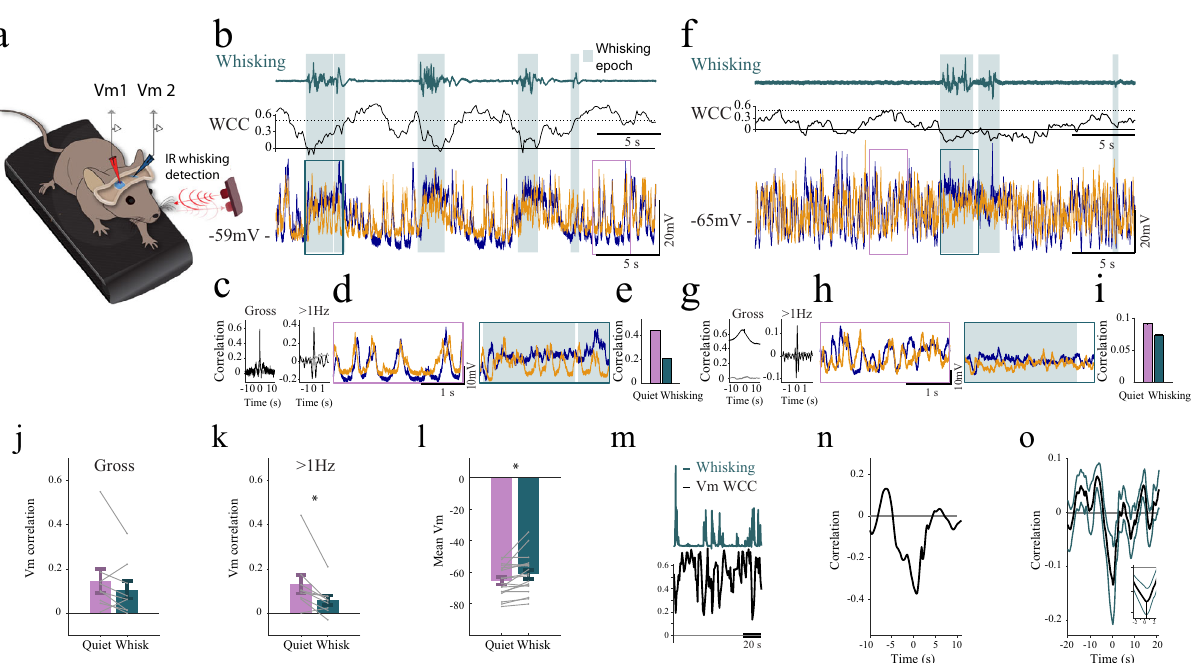
Fig. 2 Decorrelation of interhemispheric subthreshold activities during whisking. a Schematic diagram of paired whole-cell patch-clamp recordings simultaneously from both hemispheres. b An example of simultaneous dual whole-cell recordings from the right (orange) and left (blue) barrel cortices during quiet wakefulness and whisking epochs (teal background), along with the corresponding whisking activity (upper panel) and a running window membrane potential (Vm) cross-correlation (WCC, middle panel). c Cross-correlation of the membrane potential of the two neurons (shown in b ) for raw data (left) and following fi ltering above 1 Hz (right). d Expanded portions of membrane potentials during quiet wakefulness (pink frame) and whisking epochs (teal frame), showing epoch of low and high correlated activities (left, right, respectively), e The mean subthreshold cross-correlations during quiet wakefulness and whisking epochs for the example in b (mean ± SEM, quiet n = 82847, whisking n = 13154, WSRT P < 0.0001, n refers to the number of steps in the running cross-correlation). f – i Same as b – e but for another example pair (for i , mean ± SEM, quiet n = 542692, whisking n = 168311, WSRT P < 0.001, n refers to the number of steps in the running cross-correlation). j Interhemispheric subthreshold correlation during quiet wakefulness and whisking epochs for all pairs (gray lines, individual pairs, mean ± SEM, n = 9 cell pairs, two-sided paired t -test P = 0.155). k Same analysis as in ( j ) following fi ltering the membrane potential above 1 Hz (mean ± SEM, n = 9 cell pairs, two-sided paired t -test P = 0.018). l Mean membrane potential during the two states (mean ± SEM, gray lines, individual pairs, n = 9 cell pairs, two-sided paired t -test P = 0.007). m Example of the whisking envelope (teal) with its corresponding running window Vm interhemispheric cross-correlation (black, 2 seconds sliding window of 10 ms bins). n Cross-correlation of whisking envelope with running window Vm cross-correlation of the example data in m . o Mean cross-correlation of the whisking envelope with running window Vm cross-correlation, obtained by averaging data from nine pairs (black line-mean, green lines ± SEM). The vertical line in the inset marks the peak of the cross-correlation, demonstrating that a reduction in Vm correlations precedes whisking by roughly 250